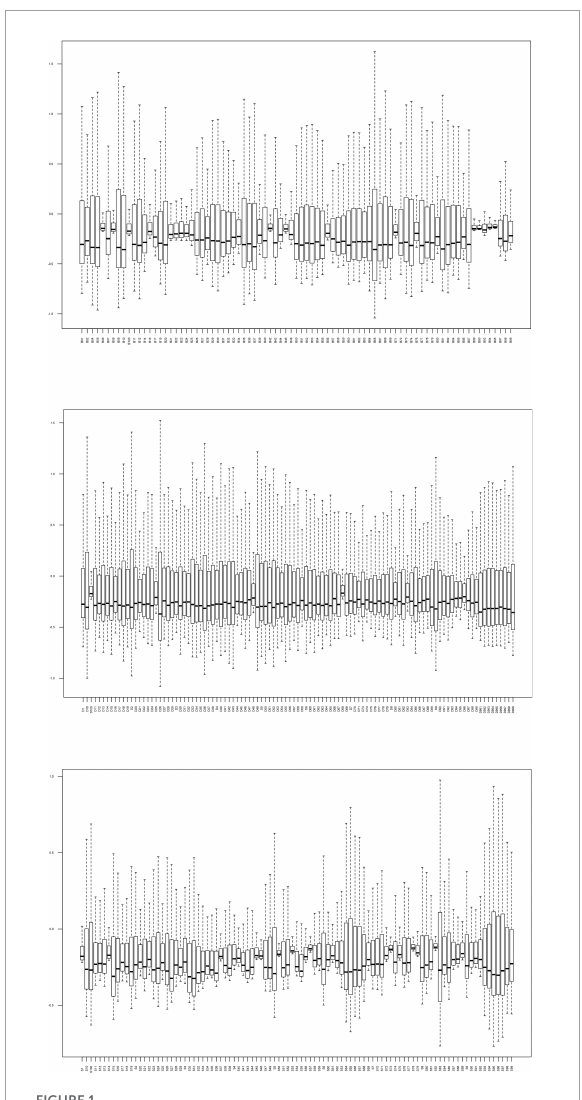
FIGURE1 Read depth for the complete mitogenome of 287 Tai-Kadai individuals in Guizhou. The horizontal axis is different individuals, and the vertical axis represents the reading depth was